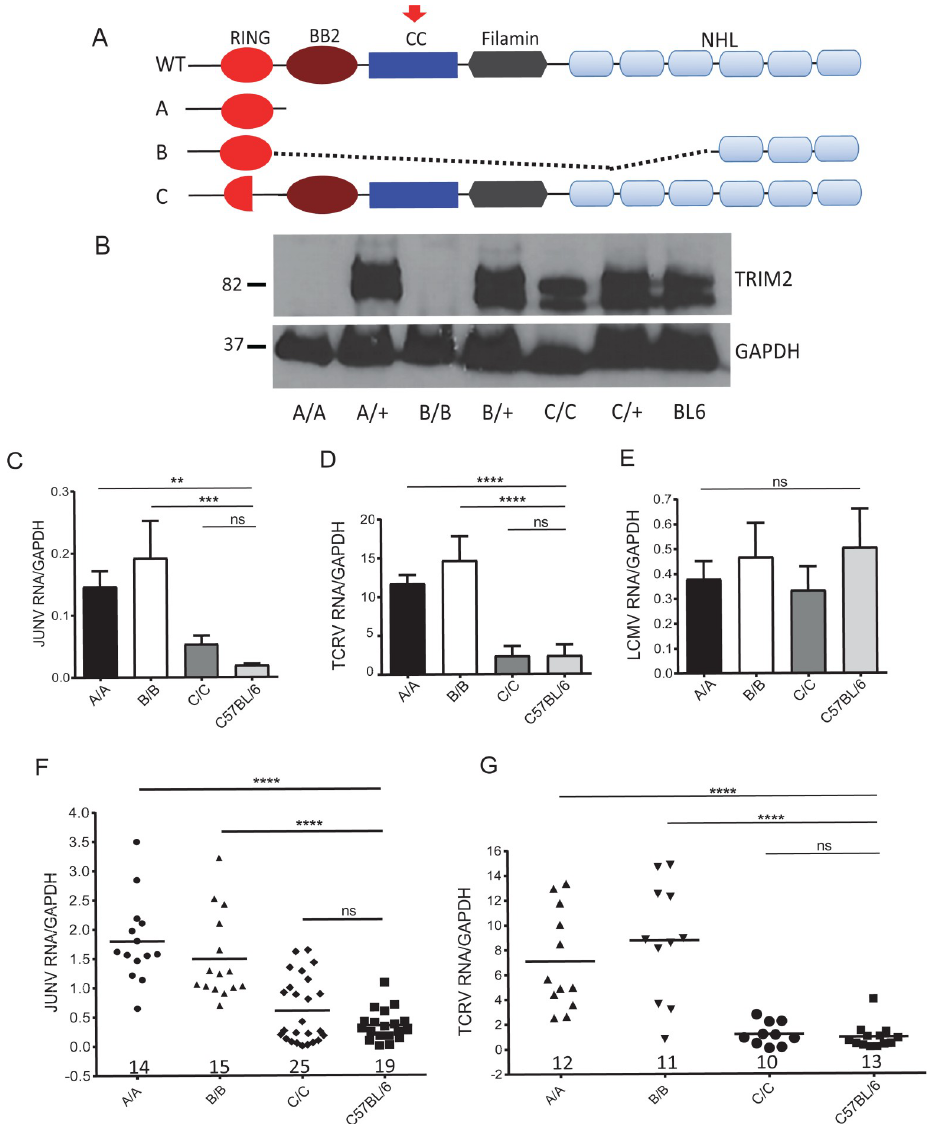
Fig 2. TRIM2 knockout mice are more susceptible to infection with new world arenaviruses. (A) Diagram of the Trim2 WT and deletion alleles in strains A, B, and C. The red arrow indicates the epitope recognized by anti-TRIM2 antisera. See also S1A and S1B Fig. (B) Western blot analysis of brain extracts from the different homozygous and heterozygous mouse strains, using TRIM2 antisera to an epitope in the CC domain (red arrow in panel A). See also S1C Fig. (C, D, and E) Primary bone marrow–derived macrophages from the different knockout strains were infected with Candid 1, TCRV, and LCMV, respectively, and analyzed by RT-qPCR for viral RNA levels at 24 hpi. Shown are the averages ± SD of 3 different experiments. One-way ANOVA was used to determine significance. �� P � 0.005; ��� P � 0.0006. See S2A Fig for infection of fibroblasts. (F) Mice of the indicated genotype were infected by intracranial inoculation with 2 × 10 4 PFU of Candid 1, and at 5 dpi RNA isolated from brains was analyzed for viral RNA. See S2B Fig for virus titers. (G) Mice of the indicated genotype were infected intraperitoneally with 2 × 10 3 PFU of TCRV by intraperitoneal injection, and at 7 dpi, RNA isolated from spleen was analyzed for viral RNA. P values were determined by unpaired t tests; ���� P � 0.0001. Number of mice in each group is shown above the x-axis. See S2C Fig for virus titers. dpi, days post infection; GAPDH, glyceraldehyde-3-phosphate dehydrogenase; hpi, hours post infection; JUNV, Junı ´ n virus; LCMV, lymphocytic choriomeningitis virus; ns, not significant; PFU, plaque-forming units; RT-qPCR, real-time quantitative PCR; TCRV, Tacaribe virus; WT, wild type.